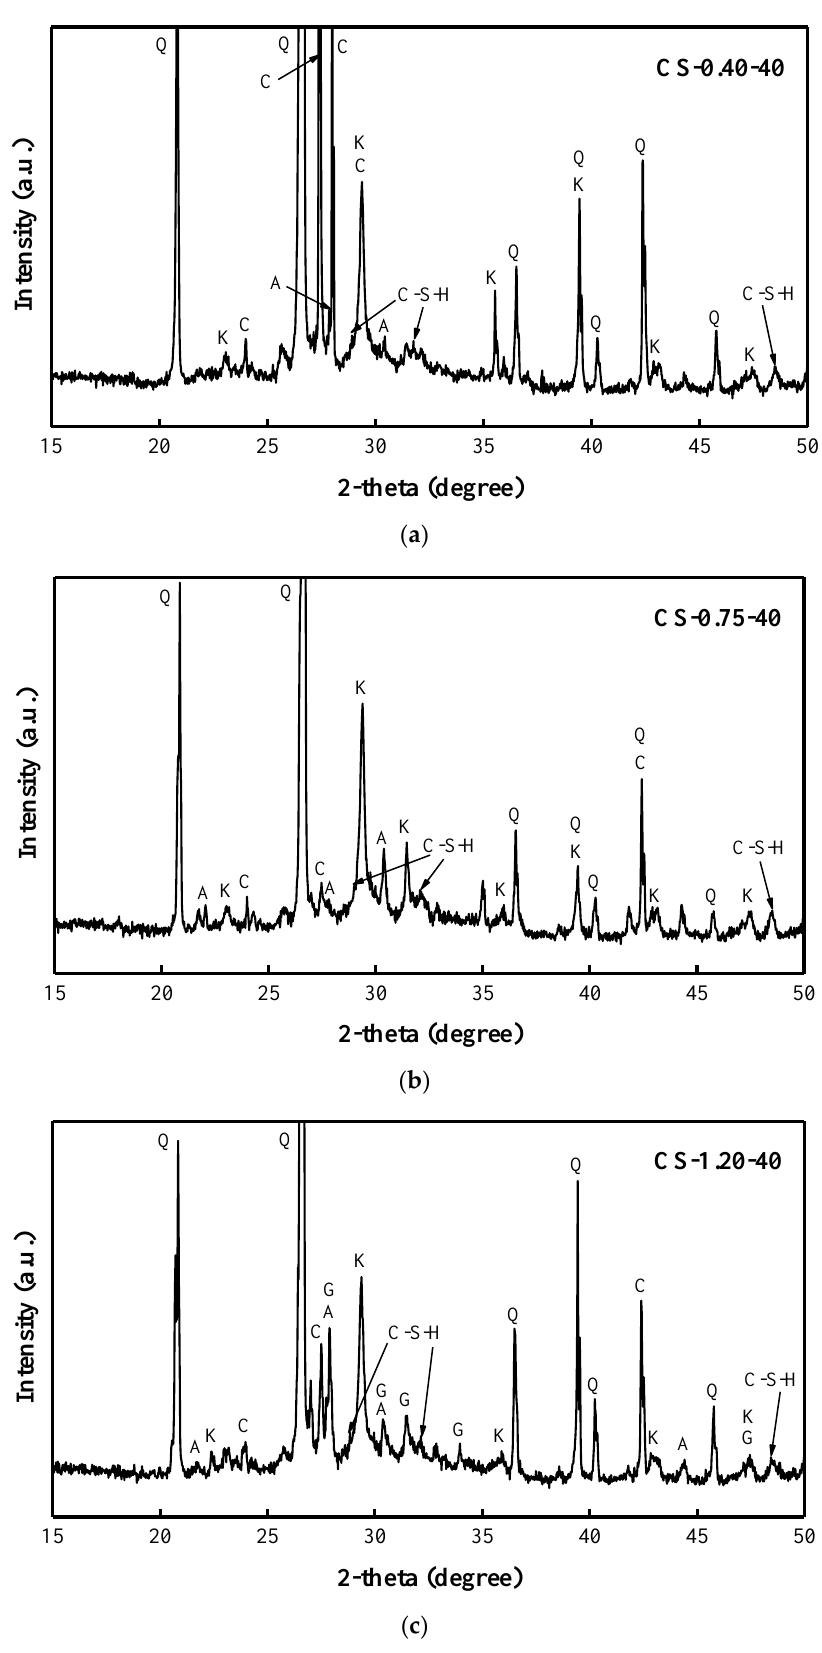
Figure 15. XRD patterns of AAM pastes cured at 40 °C for 28 days: ( a ) CS-0.40-40; ( b ) CS-0.75-40; ( c ) CS-1.20-40 (Q: quartz; K: calcite; G: gaylussite; A: anorthoclase; C: Na 2 CO 3 ; C-S-H: C-S-H gel).